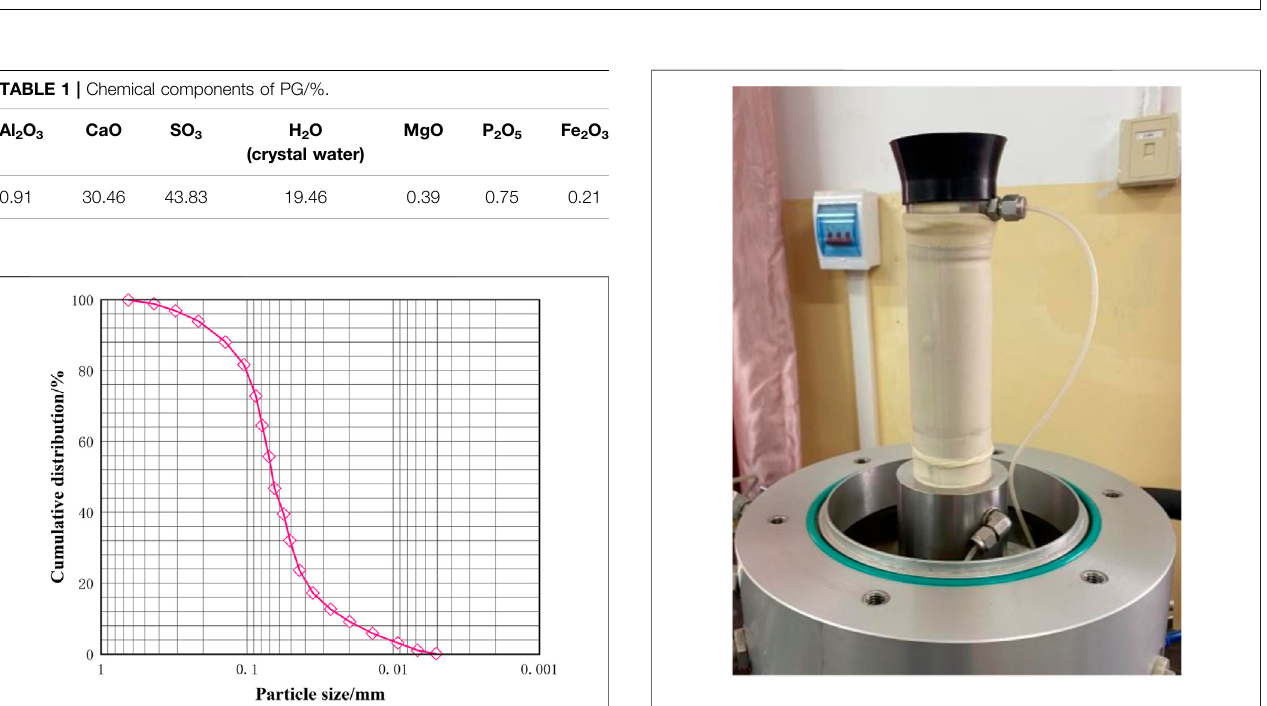
FIGURE 3 | Cumulative curve of the particle size distribution of PG.